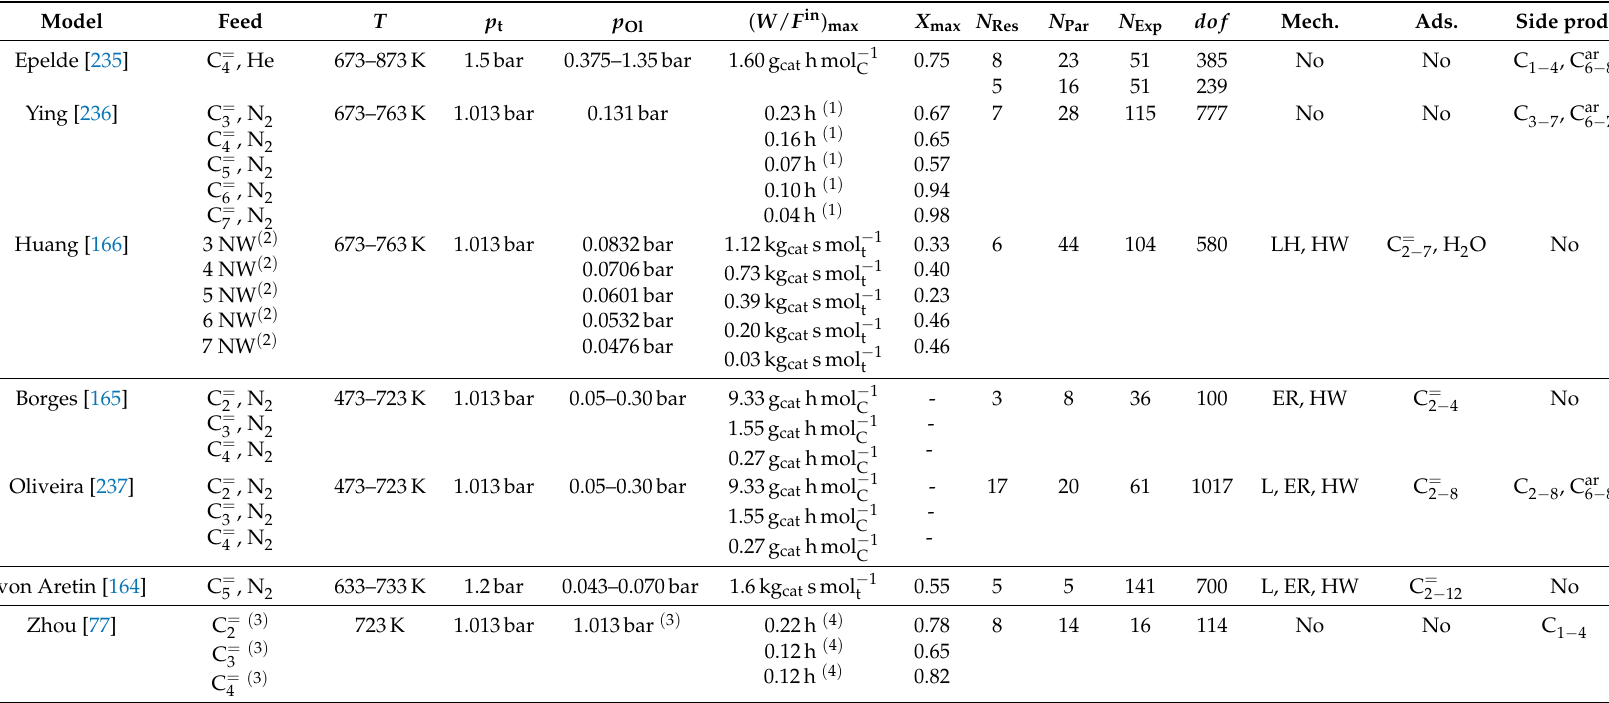
Table 2. Experimental conditions and modeling details for the kinetic models of olefin cracking: the feed components, the temperature range ( T ), the total pressure ( p t ), the partial pressure range of the feed olefin ( p Ol ) and the maximum contact time (( W / F in ) max ) with resulting conversion ( X max ) are listed. Concerning the model, the number of fitted responses ( N Res ), the number of estimated parameters ( N Par ), the number of experiments ( N Exp ) and the degree of freedom ( dof ) are shown. Finally, it is noted whether the model follows a type of a mechanistical scheme (Mech.), whether adsorption is considered (Ads.) and which side products are included (Side prod.). The line separates the different subsections. A hyphen represents missing information.